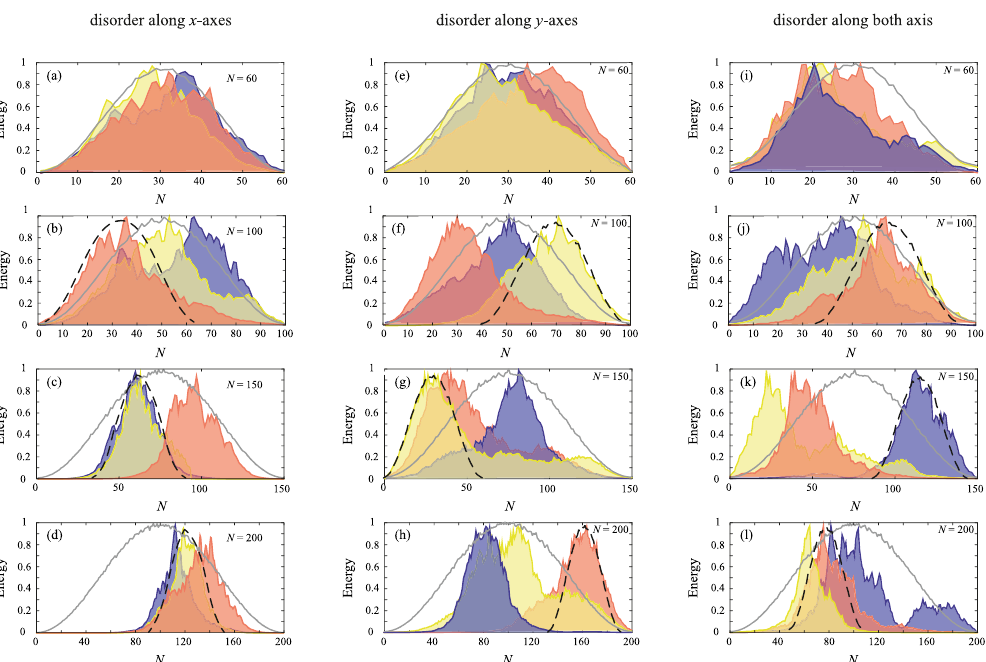
Figure 5: Electromagnetic energy distribution along chain at the accidental BIC (s-BIC). Curves with shaded area with different colors show several realization of the disorder 𝜎 = 0 . 085. Gray curves are the distribution for the structures with no disorder. (a, e, i) N = 60, (b, f, j) N = 100, (c, g, k) N = 150, (d, h, l) N = 200. The black dashed curves show the energy distribution in the chain of N = 60 with no disorder 𝜎 = 0 for